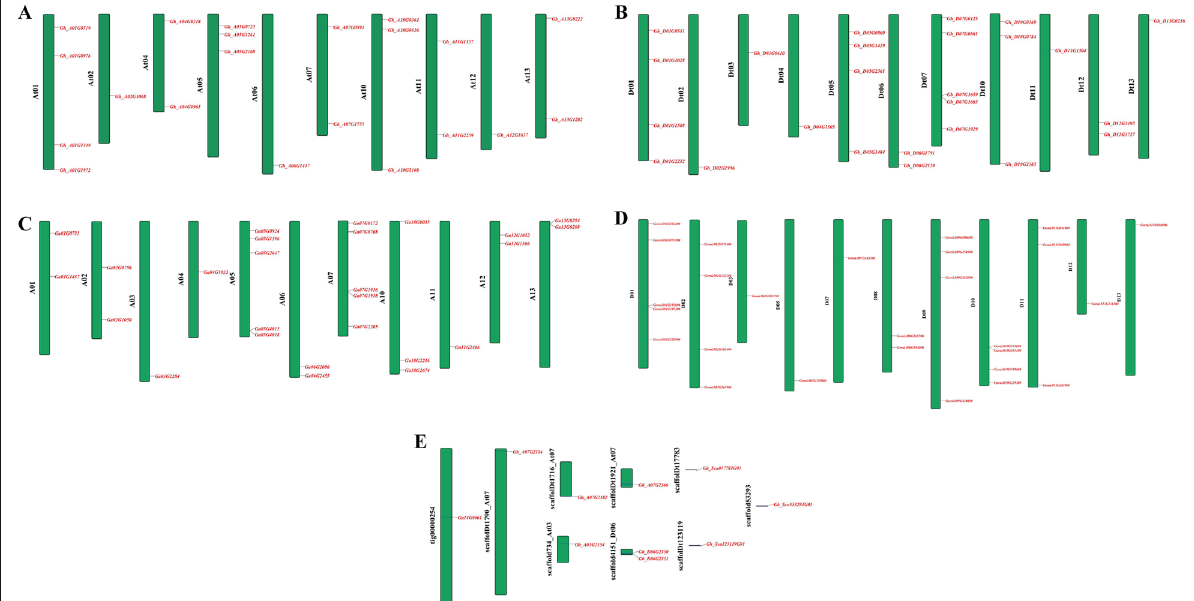
Fig. 5 Chromosomal positions of LHC genes in Gossypium species. The chromosomal location of each species was plotted based on their genome. a G.hirsutum At Subgenome b G. hirsutum Dt Subgenome c G. arboreum d G. raimondii e Scaffold distribution of the Gossypium